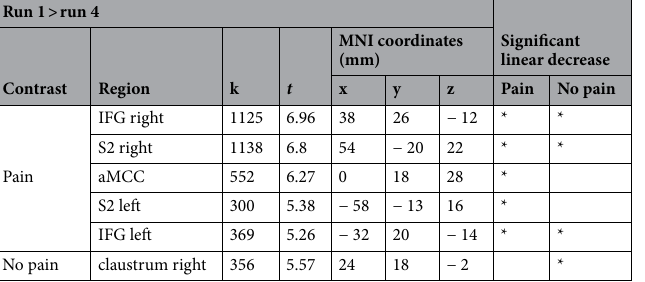
Table 2. Pain habituation. Significant brain activation clusters for contrast first vs. fourth run, separately for painful and non-painful stimulation with cluster size (k), t-value and MNI coordinates. Only the highest peak is included in case of several confluent